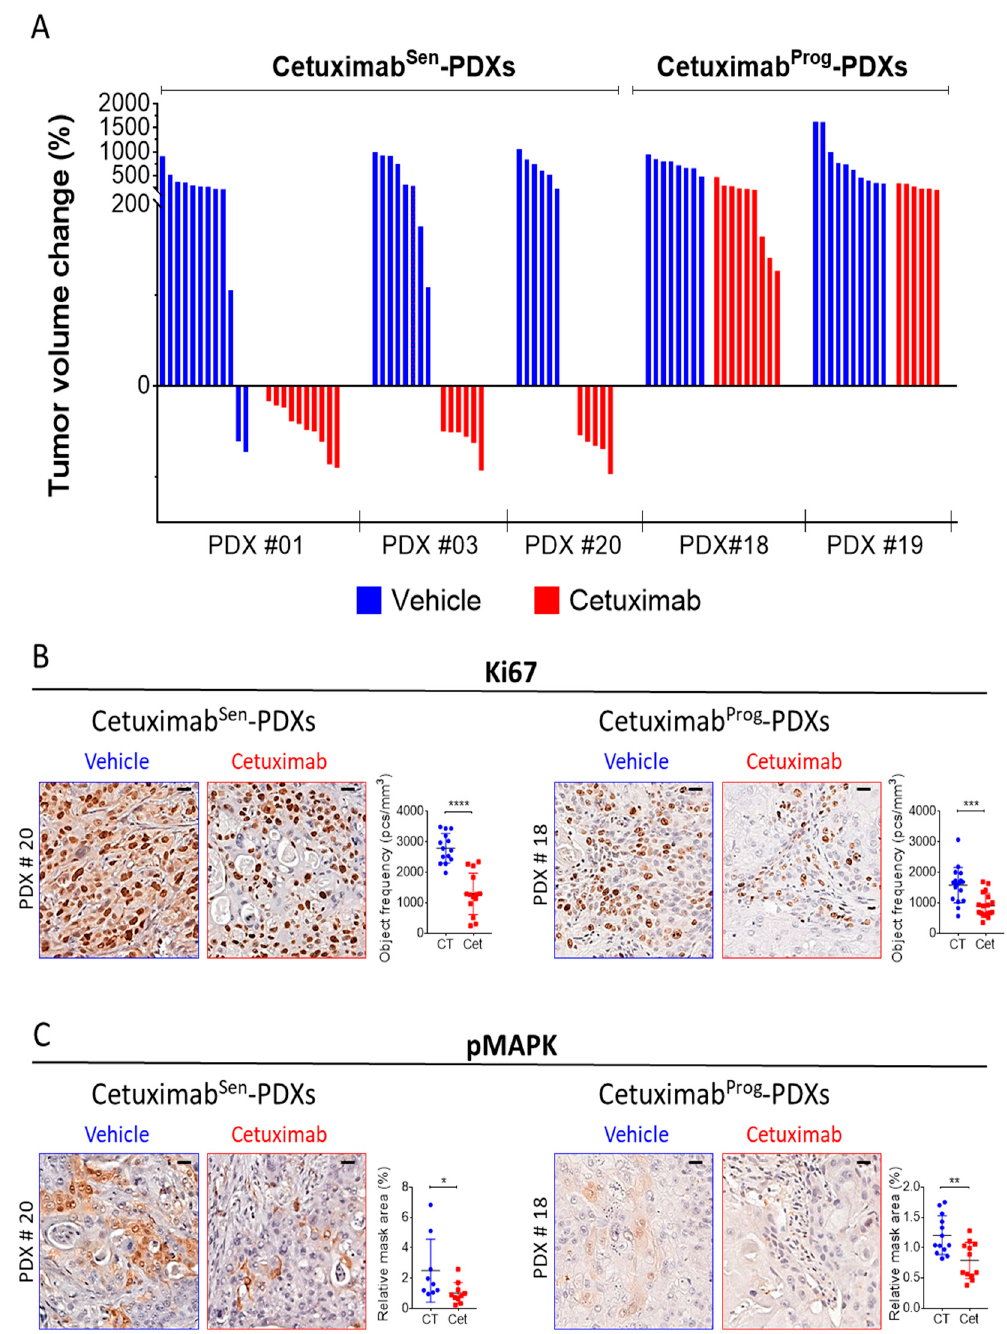
Figure 1. The diverse response of head and neck cancers–patient-derived xenografts (HNCs–PDXs) to cetuximab treatment. ( A ) Waterfall charts of reduced tumor volume (Cetuximab Sen -PDXs) (#01, #03, and #20) and increased tumor volume (Cetuximab Prog -PDXs) (#18 and #19). PDXs were transplanted and grown in NOD/SCID mice. Mice were randomized into 2 arms (tumors, n = 6–12) and treated with vehicle or cetuximab (10 mg/kg/5d) via intraperitoneal injection for an average period of 25 days. Presented are normalized tumor volumes in the end of the experiments. Representative immunohistochemistry (IHC) images and analysis of Cetuximab Sen -PDX (PDX #20) and Cetuximab Prog -PDX (PDX #18) for ( B ) Ki67 and ( C ) phosphorylated mitogen-activated protein kinase (pMAPK). Scale bar: 40X, 20 μ m. The expression levels were analyzed using the 3DHISTECH software HistoQuant, comparing 10–18 different tumor regions in the vehicle versus cetuximab treatment groups. Statistical significance was calculated by unpaired t -test (* p < 0.05, ** p < 0.01, *** p < 0.001 and **** p < 0.0001).